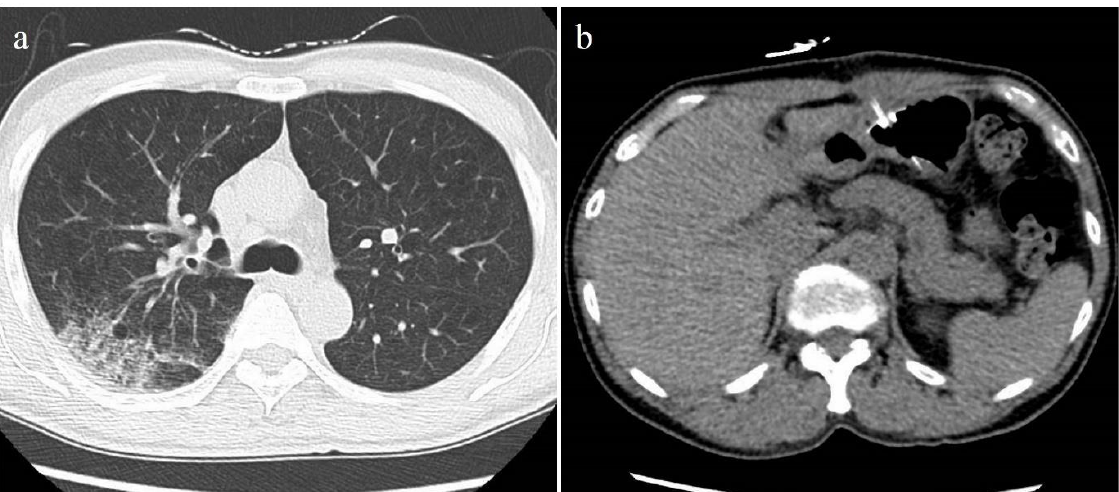
Figure 4. Unenhanced axial CT images of a 57-year-old male patient with non-severe COVID-19 pneumonia. ( a ) Chest CT showed the ill-defined ground-glass opacity in the middle lobe of the right lung. The lung severity score was 0.4. ( b ) No abnormal findings were observed in the pancreas and liver on the abdominal CT. The CT-FVF of the pancreas was 4.5 % and the CT attenuation value of the liver was 61.2 HU.